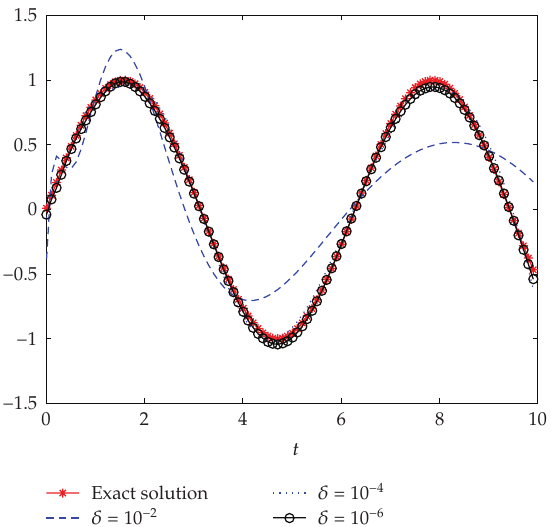
Figure 11: Example 3.11: the stability of the approximate solution.